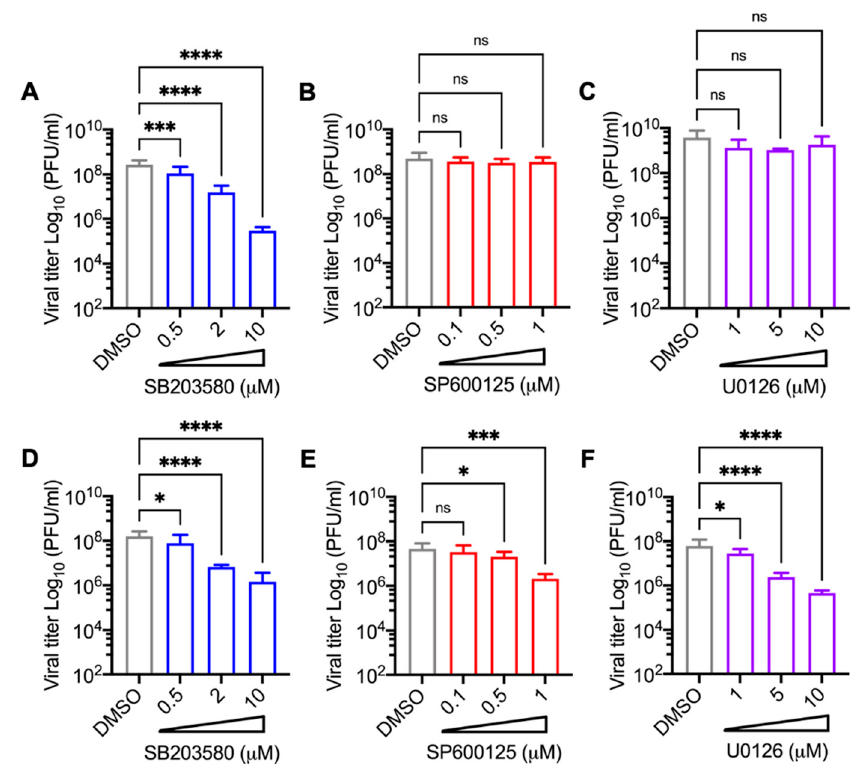
Figure 4. MAPK p38 inhibitor SB203580 reduces MAYV titers in HDFs and HeLa cells in a dose- dependent manner. HDFs ( A – C ) or HeLa ( D – F ) cells were pre-treated with increasing concentrations of SB203580, SP600125, or U0126 and then infected with MAYV as previously performed. After 24 h of infection, MAYV titers were measured in cell supernatants using plaque assay. Statistically significant differences were evaluated with the One-way ANOVA test followed by Dunnett’s post-test: * p < 0.05; *** p < 0.001; **** p < 0.0001 and ns: non-significant.